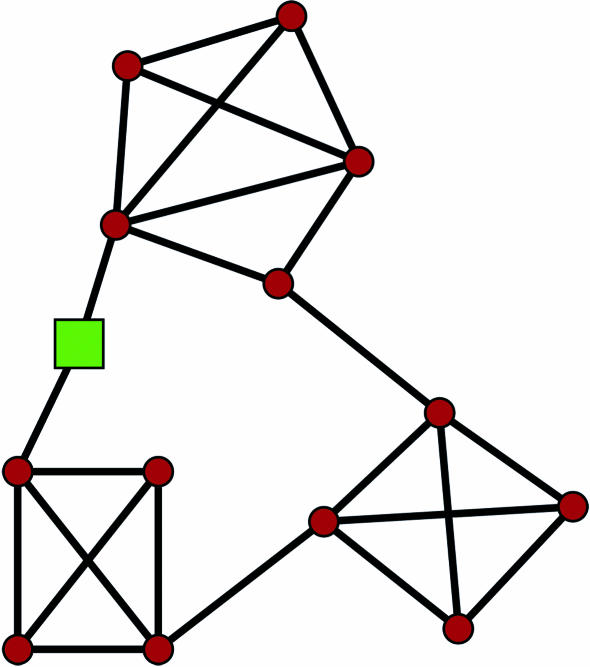
Simple Graph Made of Three ComponentsThe MCL is able to identify the three clusters. The analysis of the instability of the clustering described in Clustering and Entropy Measure identifies the node coloured in green as unstable.